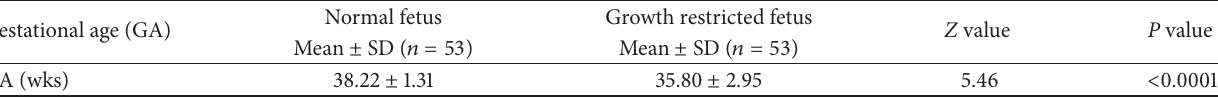
Table 1: The comparison of gestational age (GA) by ultrasonography (USG) in study groups.